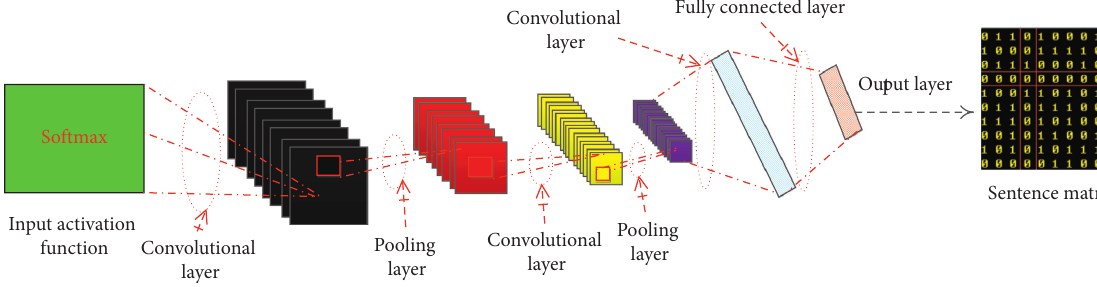
Figure 3: CNN syntax network model.